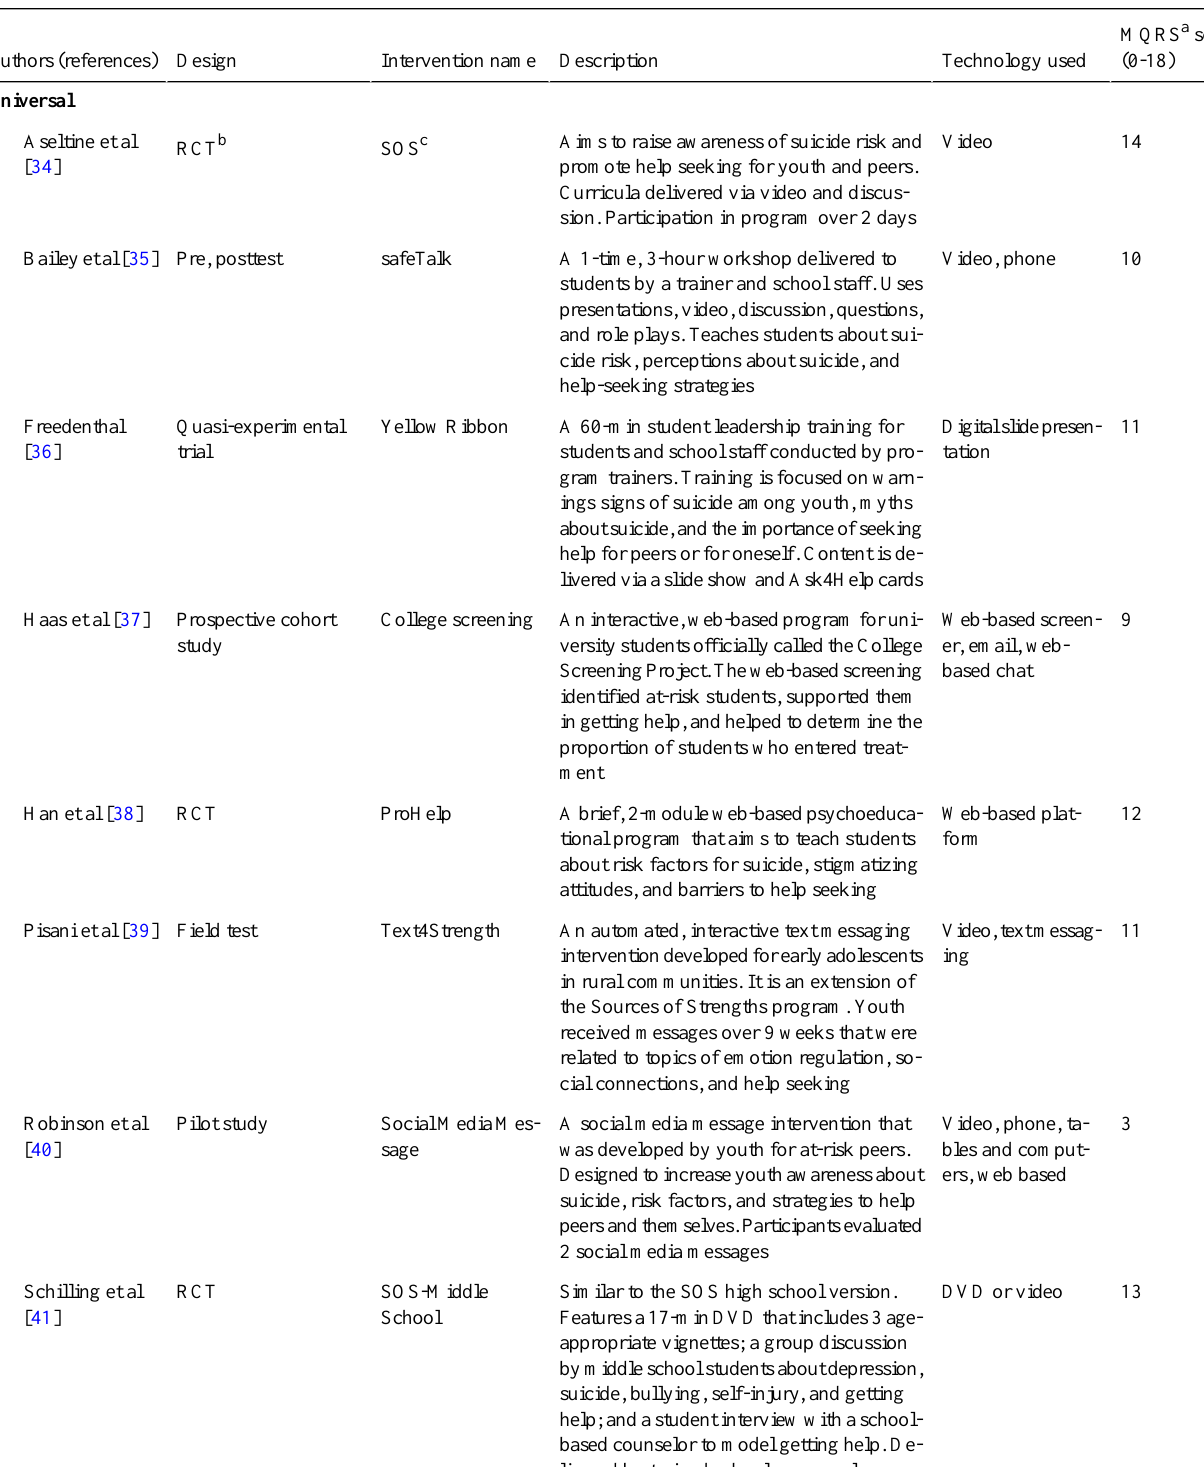
Table 2. Study characteristics